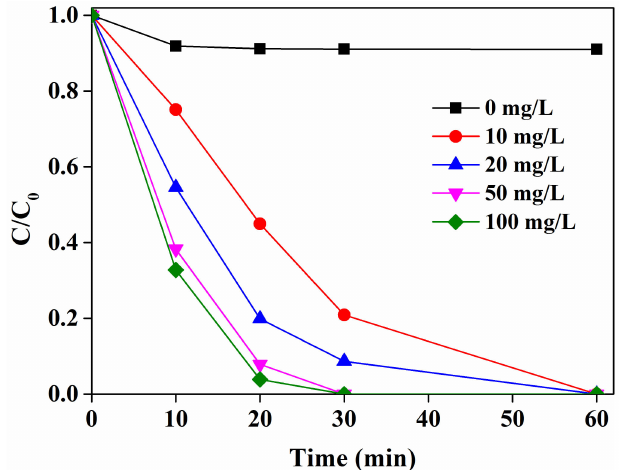
Figure 3. E ff ect of LaCoO 3 loading on SMX degradation in the LaCoO 3 / PAA system. SMX = 50 µ M, PAA = 660 µ M, pH 7, 25 ◦